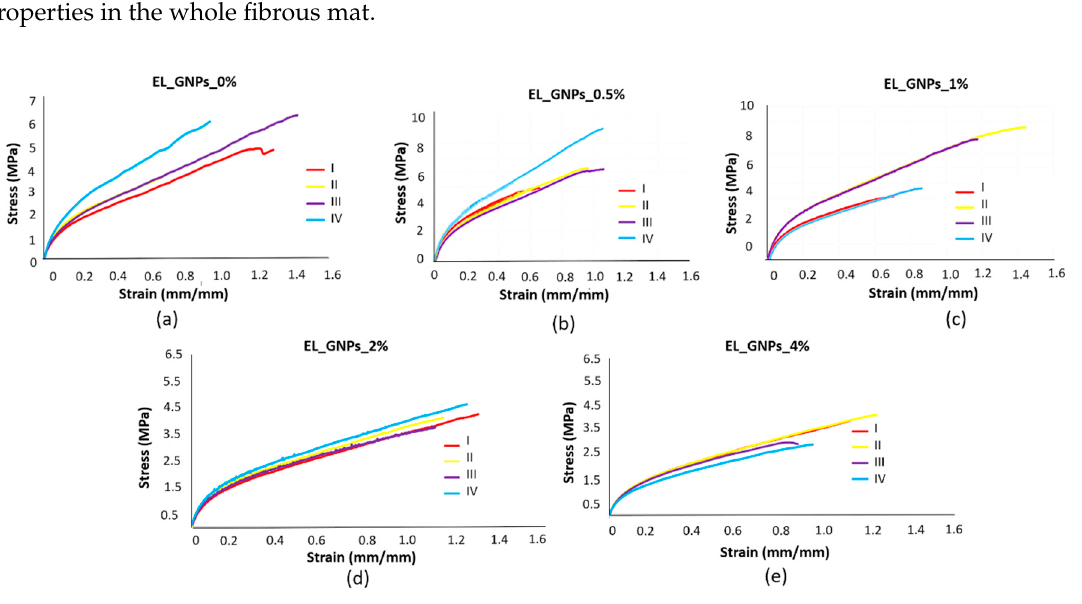
Figure 8. Stress strain curve of: ( a ) EL_GNPs_0%, ( b ) EL_GNPs_0.5%, ( c ) EL_GNPs_1%, ( d ) EL_GNPs_2% and (e) EL_GNPs_4%. (I–IV, curves from each dog-bone shaped specimen per mat).